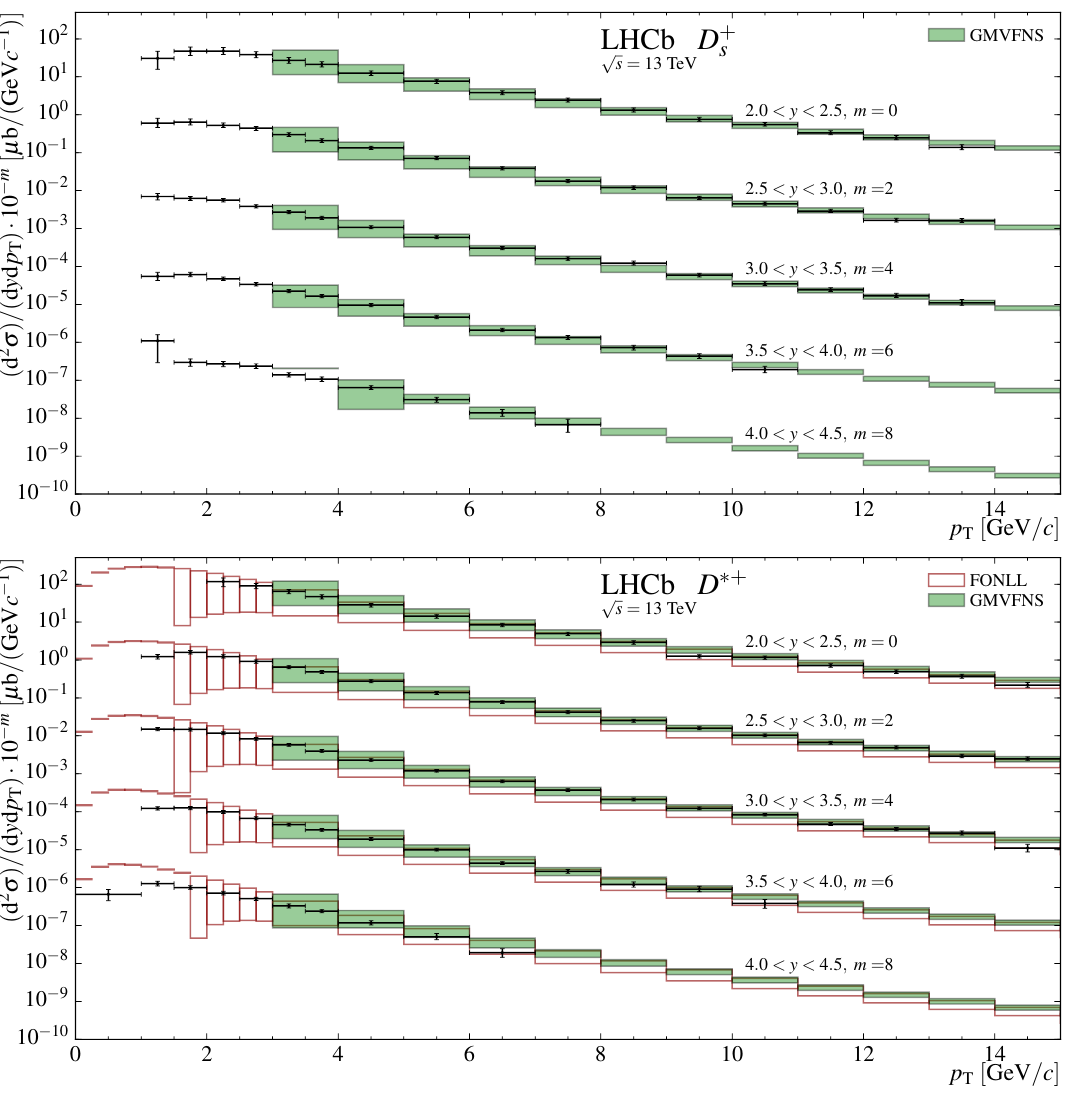
Figure 6. Measurements and predictions for the absolute prompt (top) D + cross-sections at p s = 13 TeV. Each set of measurements and predictions in a given rapidity bin is o(cid:11)set by a multiplicative factor 10 (cid:0) m , where the factor m is shown on the plots. The boxes indicate the 1 (cid:27) uncertainty band on the theory predictions. In cases where this band spans more than two (cid:6) orders of magnitude only its upper edge is indicated.